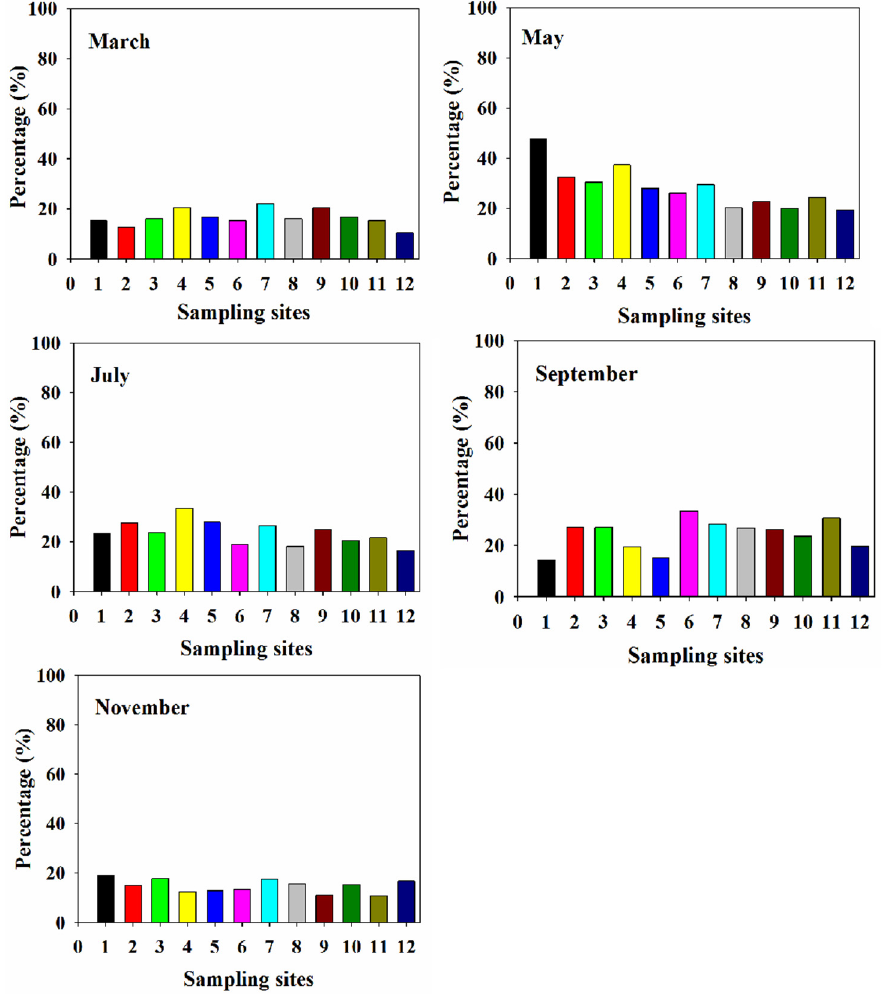
Figure 4. The proportion of dissolved reactive iron (DrFe) to total dissolved iron (TdFe) in Sishili Bay in different months of 2018.